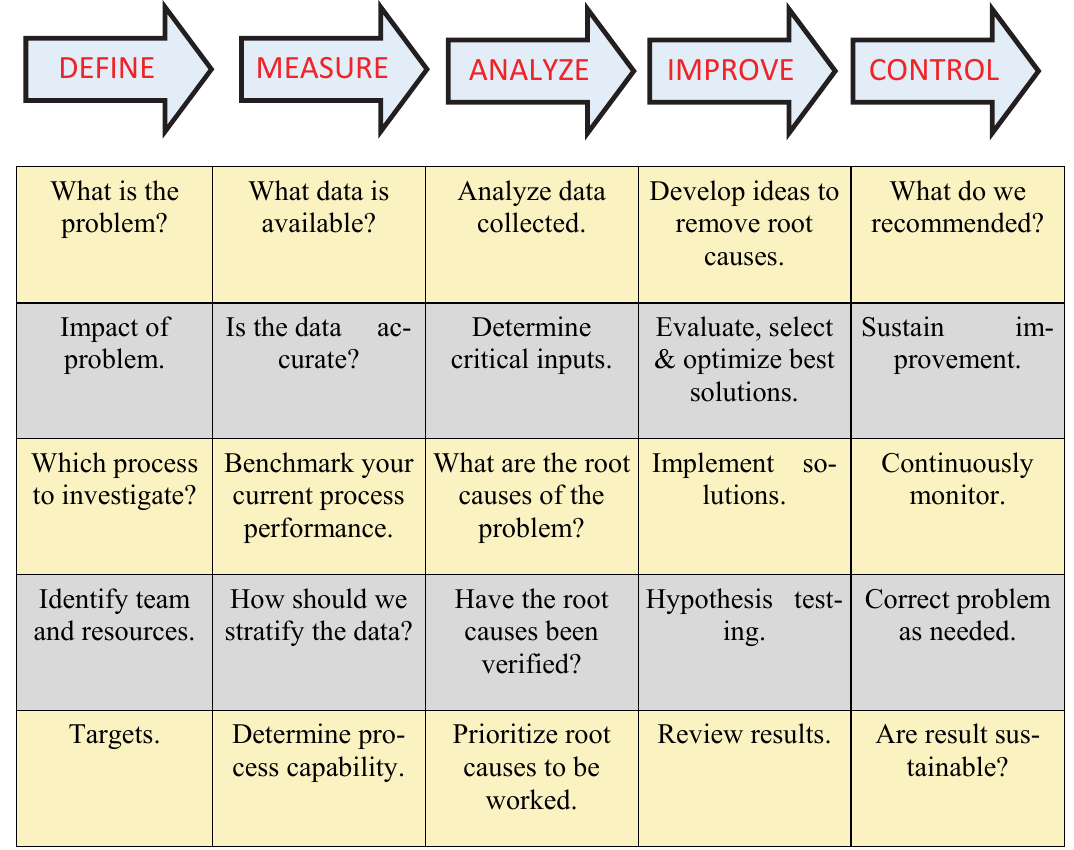
Fig. 2. The DMAIC (Define, Measure, Analyze, Improve, and Control) process Concept of Capacity